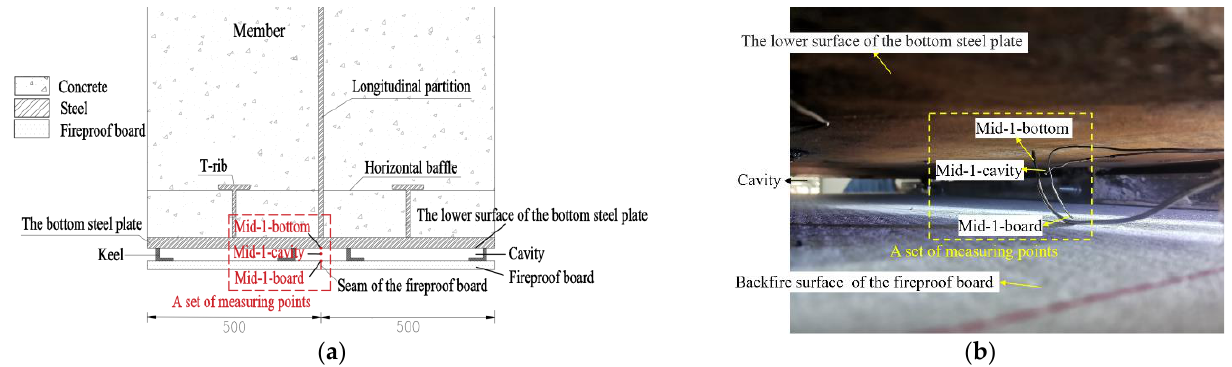
Figure 9. Position diagram of measuring points at the bottom of steel shell (unit: mm). ( a ) The lower surface of the bottom steel plate and measuring points position; ( b ) the specific location of the meas- uring points.